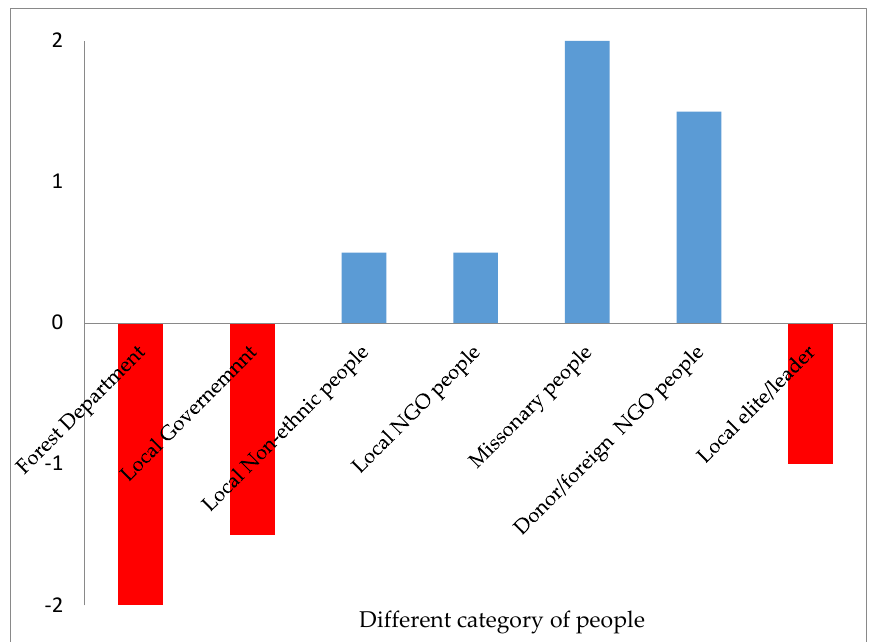
Figure 2. Social relationship of ethnic minorities with other people in the community.